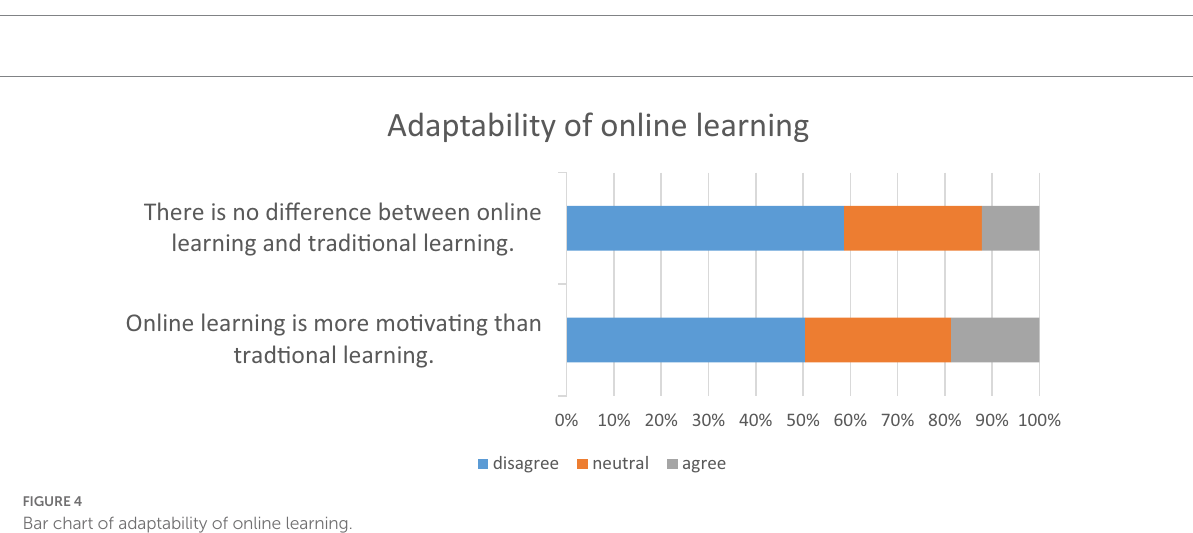
FIGURE 4 Bar chart of adaptability of online learning.